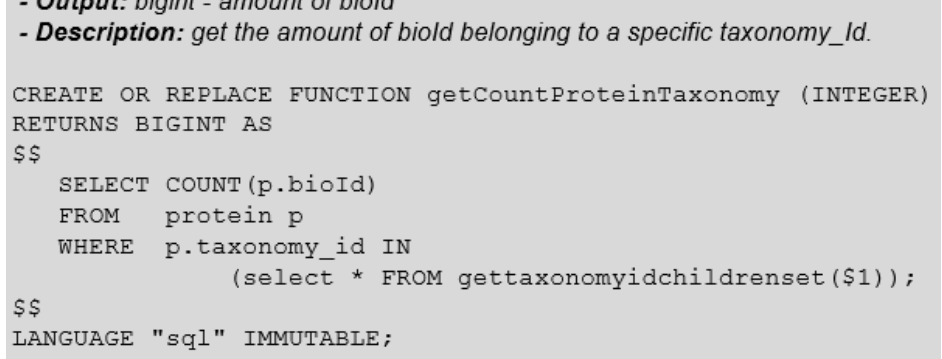
Figure 11. Function: